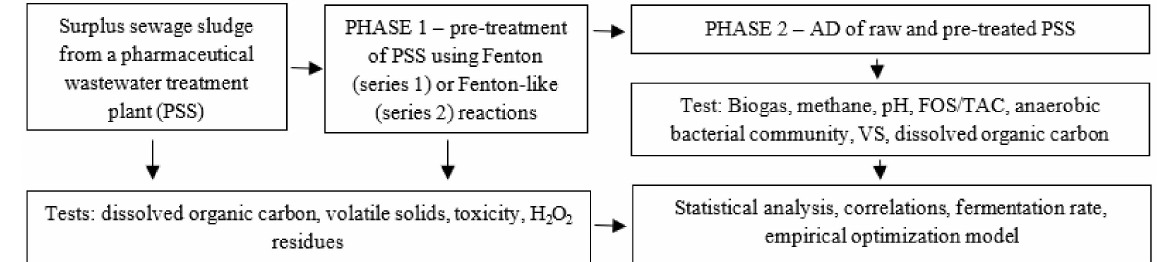
Figure 1. Flowchart of the experiment, tests and calculations.